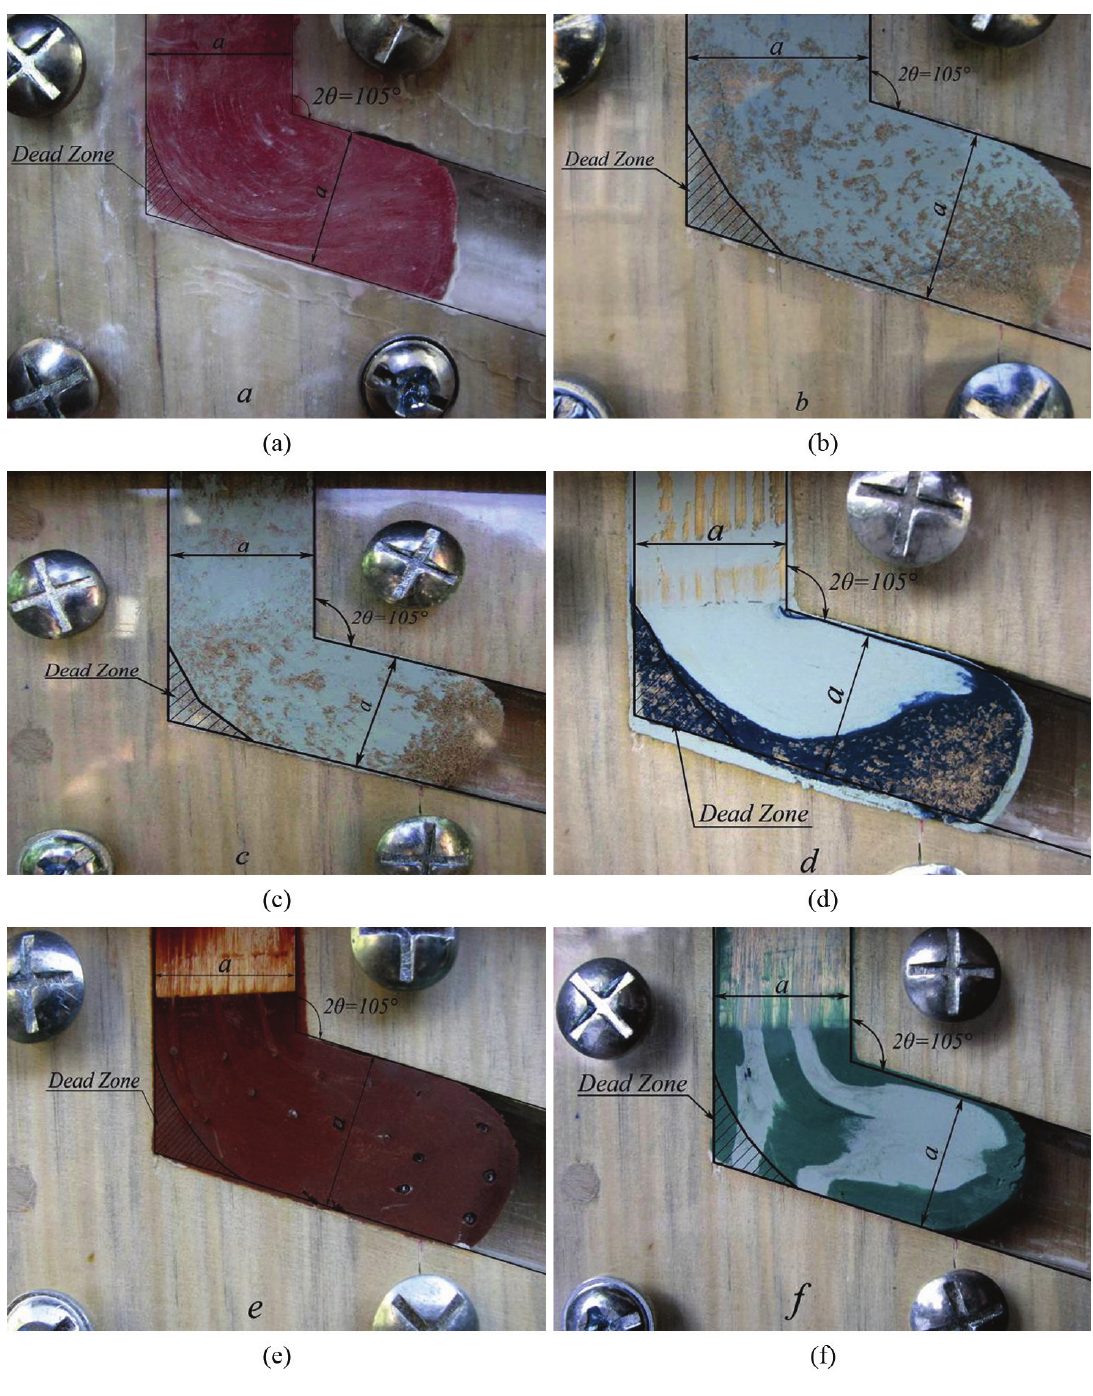
Figure 9. The physical simulation-derived geometries of observable dead zones during ECAE of plasticine workpieces models through the dies with 2 θ =105° : S/a 2 = 0.1037 ( a ); S/a 2 = 0.1267 ( b ); S/a 2 = 0.1259 ( c ); S/a 2 = 0.2177 ( d ); S/a 2 = 0.1016 ( e ); S/a 2 = 0.1476 ( f